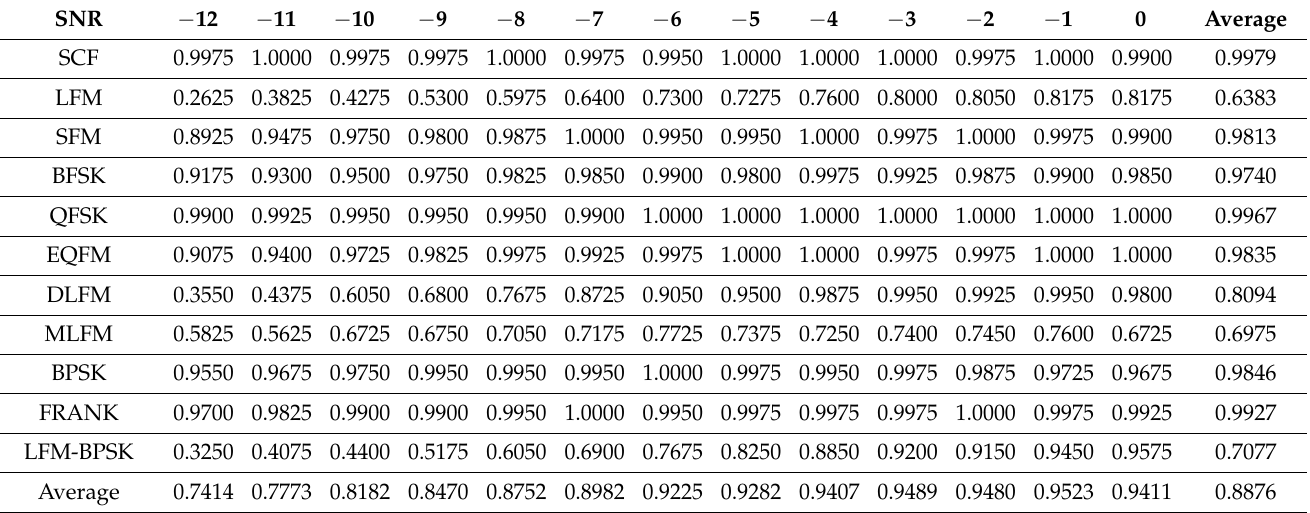
Table A10. Semi-supervised classification results with the datasets in Situation Dataset 4 ( T cycle = 200, NUM = 276).